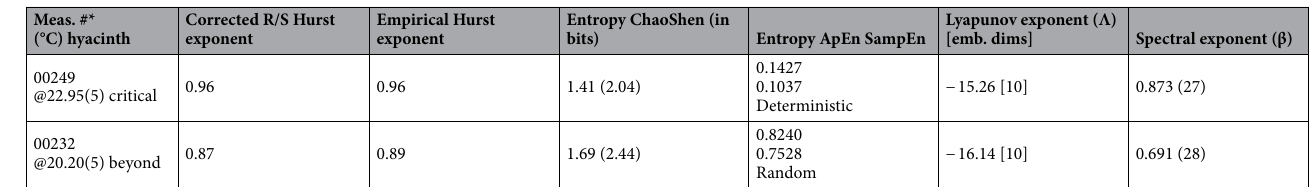
Table 1. Complexity metrics of a droplet of the electrolytic medium containing a collection of the living pollen tubes of hyacinth at a critical (optimum) growth temperature and beyond. *Raw data files are available upon reasonable